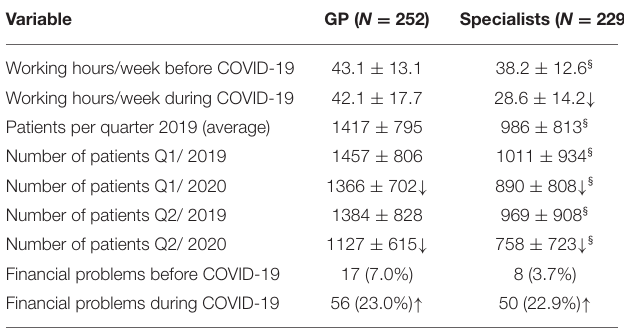
TABLE 2 | Work-related aspects before and during the COVID-19 pandemic.